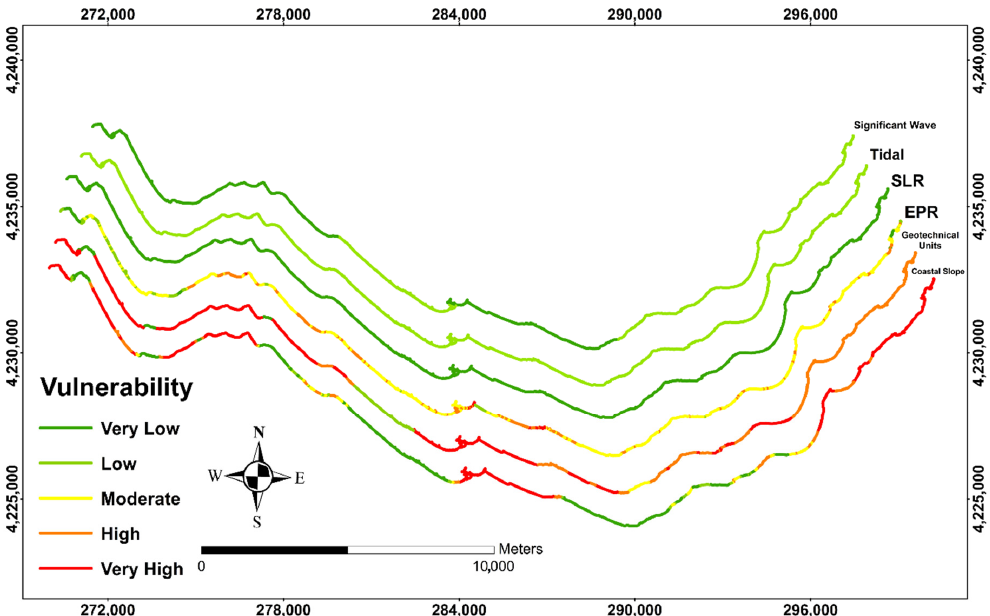
Figure 3. Spatial variations of each of the variables used in the Coastal Vulnerability Index (CVI) calculations along the coastline.